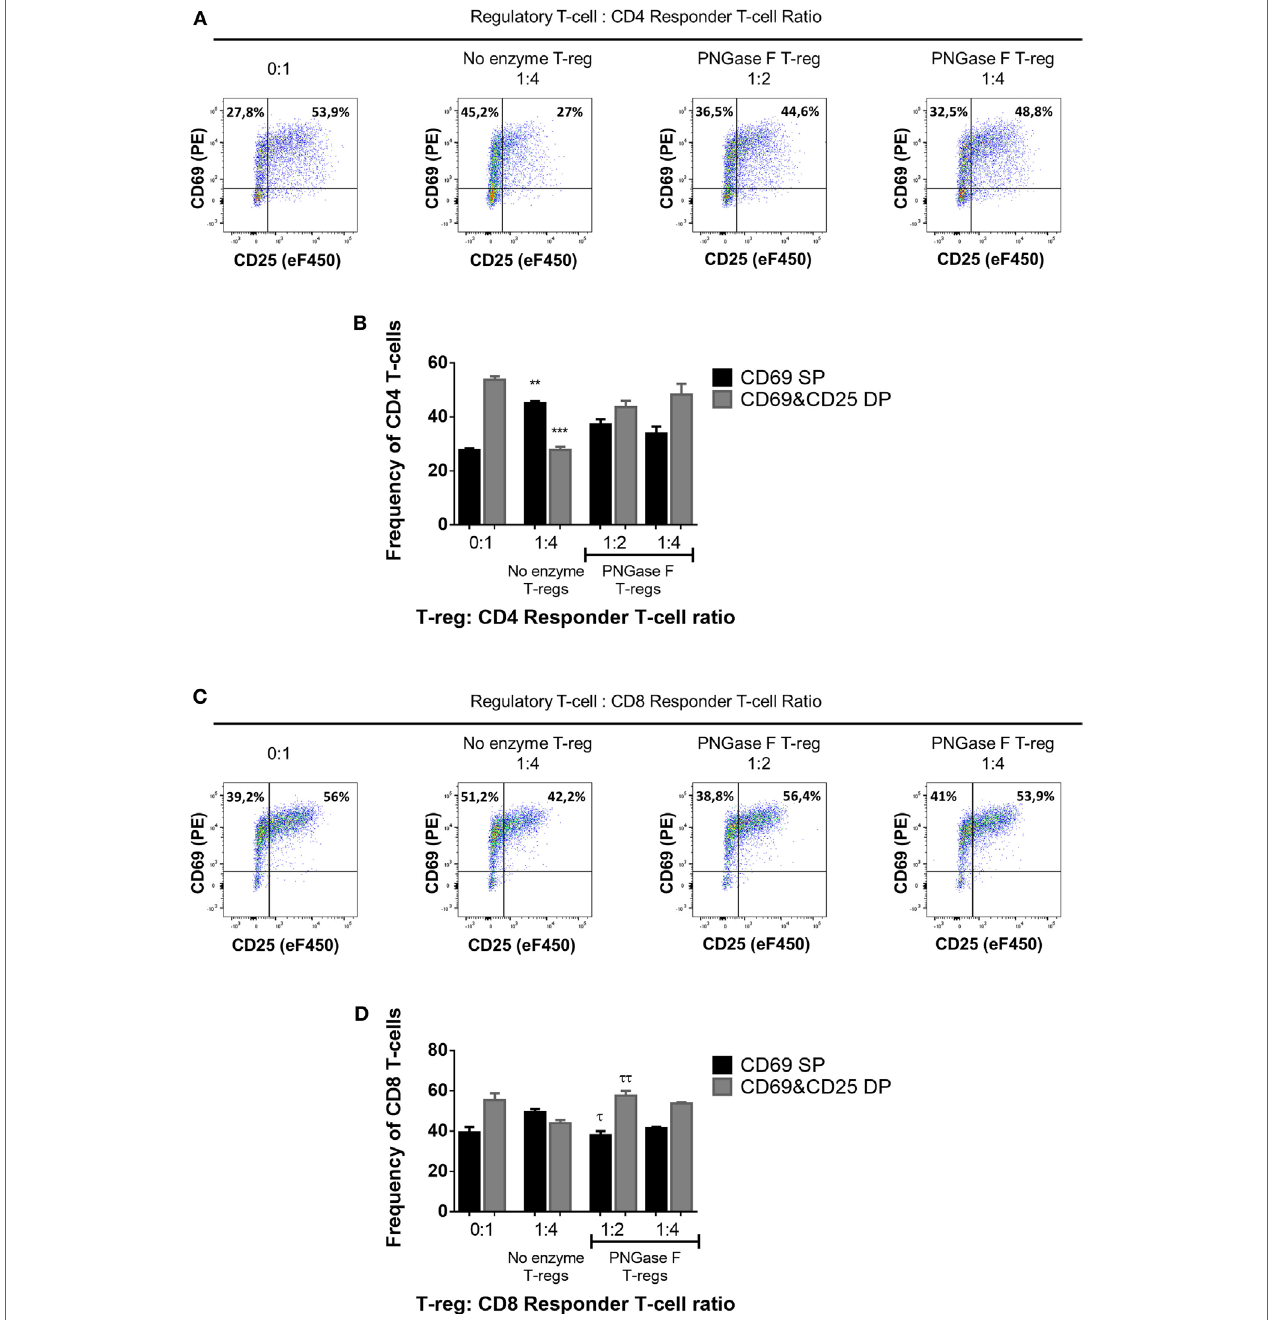
FigUre 7 | Manipulation of surface N -glycosylation impairs the early suppressive potency of murine Treg. (a–D) Fluorescence-activated cell sorting-purified CD4 + (a,B) and CD8 + (c,D) Tconv were cocultured in the presence of CD4 − CD8 − antigen-presenting cells without Treg (0:1) and with no enzyme or PNGase F-treated Treg at Treg: responder T-cell ratios of 1:2 and 1:4 for 24 h with anti-CD3 stimulation. Suppressive function was evaluated based on inhibition of (a,B) CD4 + and (c,D) CD8 + responder T-cell upregulation of CD25 and CD69 after 24 h coculture and is presented as the frequencies of CD69 single positive (CD69 SP) and CD69 and CD25 double positive (CD69&CD25 DP) cells for cocultures containing no enzyme and PNGase F-treated Treg. (a,c) Representative flow cytometric dot plots of the expression of the activation markers CD25 and CD69 on Tconv populations. The frequencies of CD69 SP (top left quadrant) and CD69 and CD25 double positive (top right quadrant) Tconv are shown for four coculture conditions: no Treg (0:1); no enzyme Treg at 1:4 Treg: responder T-cell ratio; PNGase F-treated Treg at 1:2 Treg: responder T-cell ratio and PNGase F-treated Treg at 1:4 Treg: responder T-cell ratio. (B,D) Graphs showing the relative distribution and frequency of cells with differential CD69 and CD25 expression in the different culture conditions. Data represent mean ± SD ( n = 3 technical replicates). Results were confirmed in three independent experiments. Statistical analysis was performed by permutation test with an unpaired design comparing the coculture with the different Treg populations to the no Treg condition (* p value ≤ 0.1; ** p value < 0.05; *** p value < 0.01) and between the PNGase F and the no enzyme Treg cocultures ( τ p value ≤ 0.1; ττ p value <